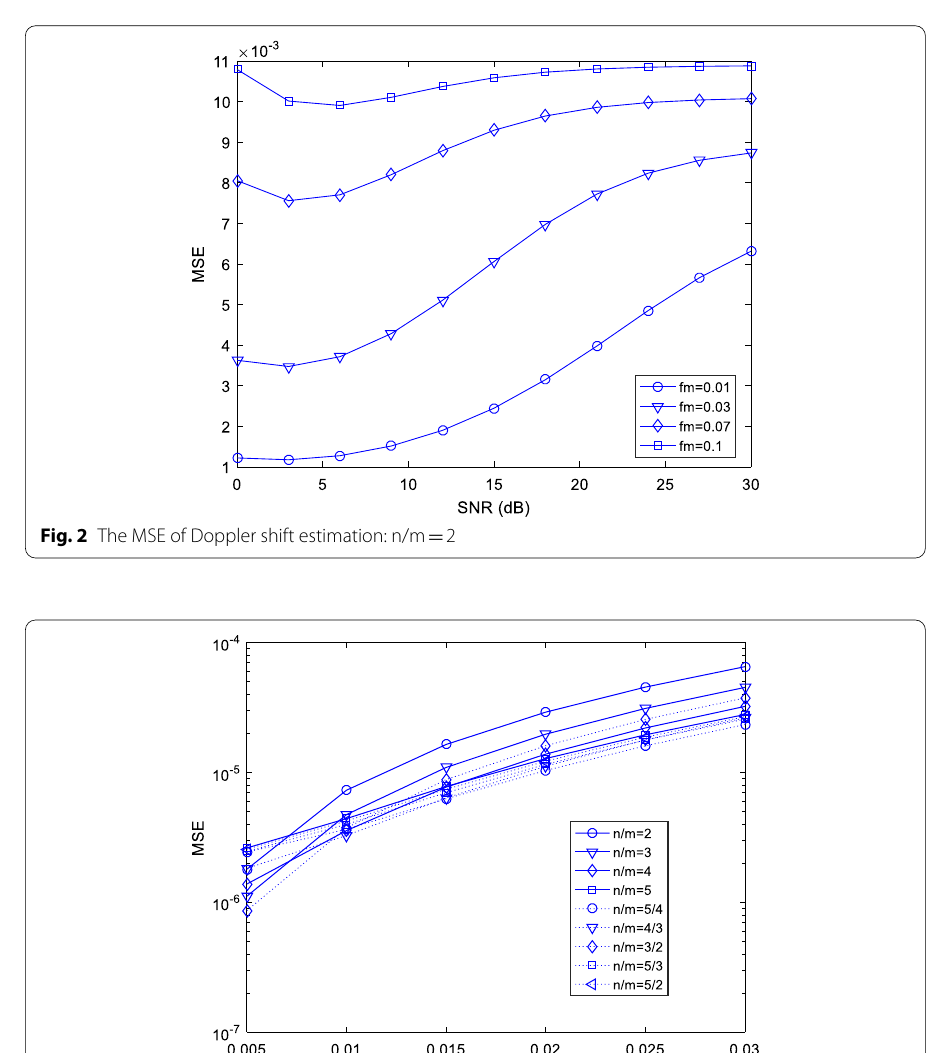
Fig. 3 The MSE of Doppler shift estimation for different (cid:31) T s